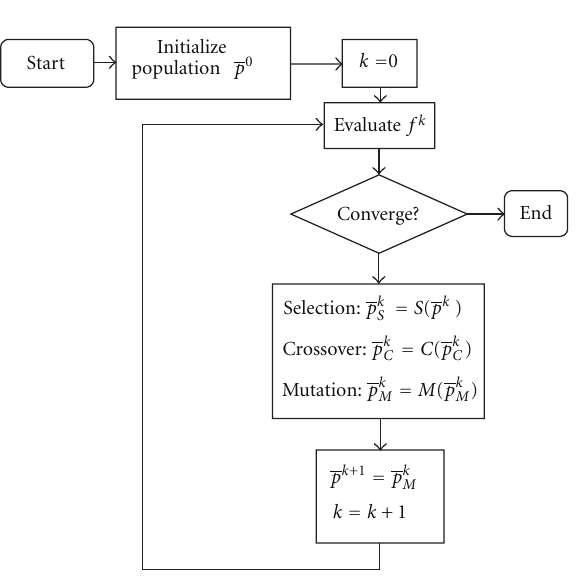
Figure 14: Simple GA